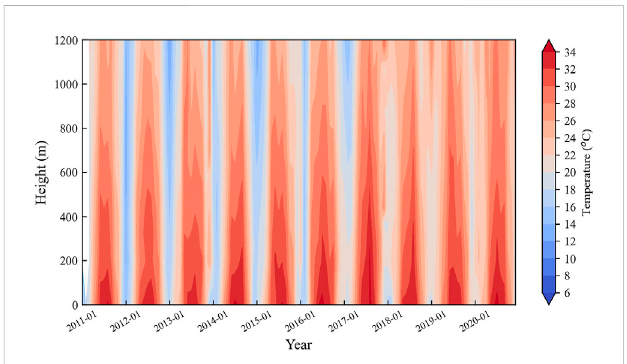
Changes in mean annual virtual temperature in the upper level atmosphere below 1,200 m over the Pearl River Estuary (PRE) in 2011 –